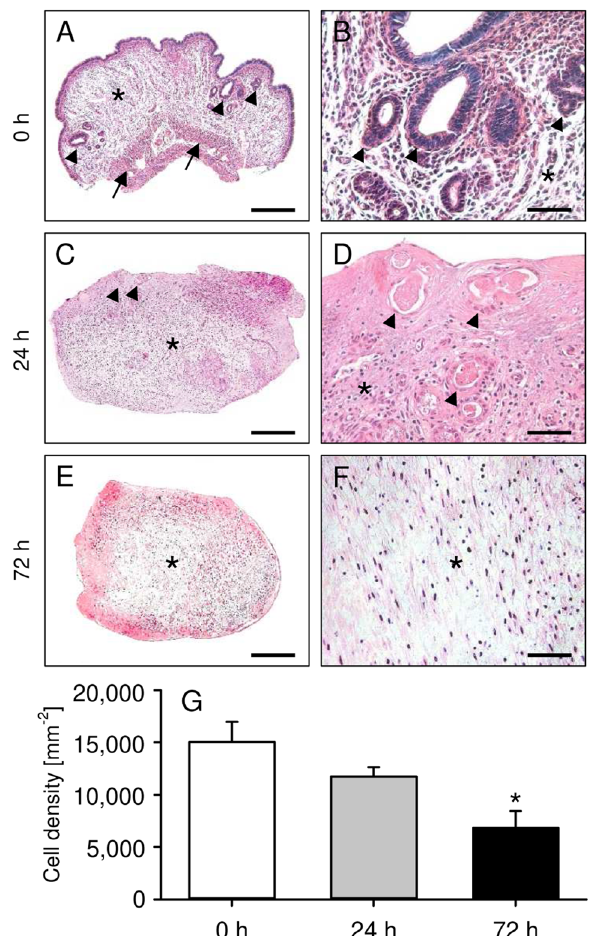
Figure 1. ( A – F ) HE-stained sections of freshly isolated (0 h; A , B ) as well as 24-h- ( C , D ) and 72-h-precultivated ( E , F ) uterine tissue samples from C57BL/6-TgN(ACTB-EGFP)1Osb/J donor mice (arrows = myometrium with perimetrium; arrowheads = endometrial glands; asterisks = endometrial stroma). Scale bars: ( A , C , E ) 300 µm; ( B , D , F ) 60 µm. ( G ) Cell density (mm −2 ) in freshly isolated (0 h; white bars; n = 5) as well as 24-h- (grey bars; n = 5) and 72-h-precultivated (black bars; n = 5) uterine tissue samples from C57BL/6-TgN(ACTB-EGFP)1Osb/J donor mice. Mean ± SEM; *P < 0.05 vs. 0